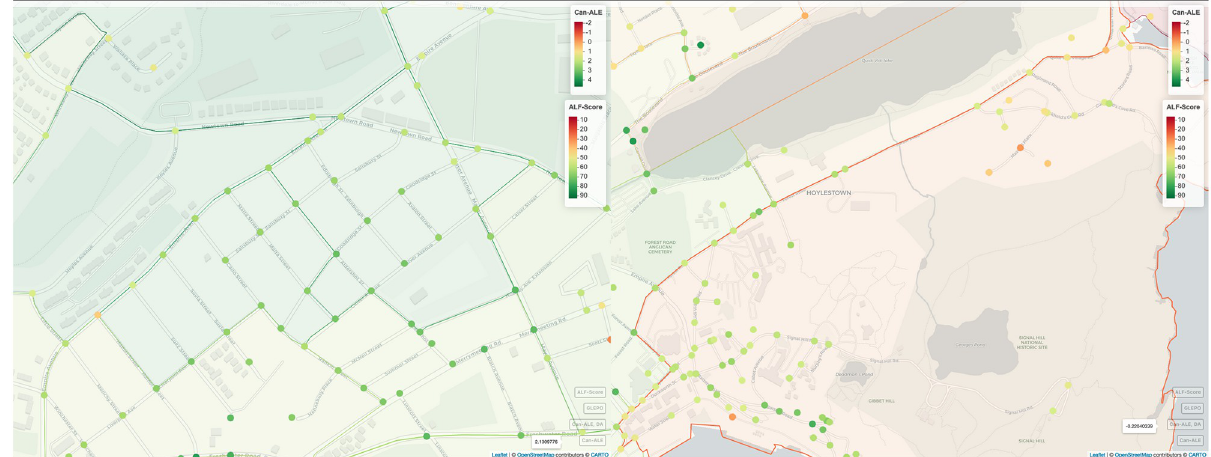
Fig 7. Examples of where ALF–Score and Can–ALE do and do not agree. Each DA polygon is represented by a single Can–ALE value while each circle represents an ALF–Score. Left: Downtown St. John’s, NL, shows a strong agreement among the two measures. Right: Signal Hill region, St. John’s, NL, shows a strong disagreement between the two measures. Note: Can–ALE is represented as an overlay with a small opacity/alpha and is visualized with a significantly lighter colors due to this transparency. Legends and border lines represent the actual colors. (Maps generated through RStudio [31] Version 1.2 using mapview package from rstudio.com with OpenStreetMap used as its base